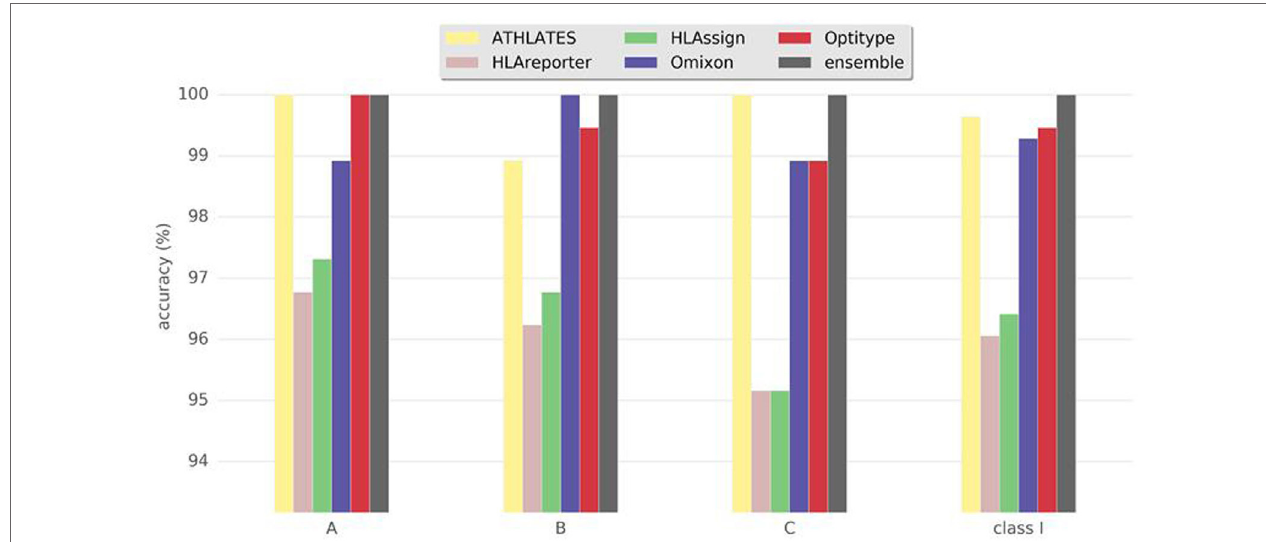
FigUre 1 | Accuracy of human leukocyte antigen (HLA) interpretation programs to determine HLA class I alleles in the Finnish Red Cross Blood Service dataset comprising 93 Finnish individuals. Concordance rate to standard clinical HLA typing togehter with ensemble results are shown for each program